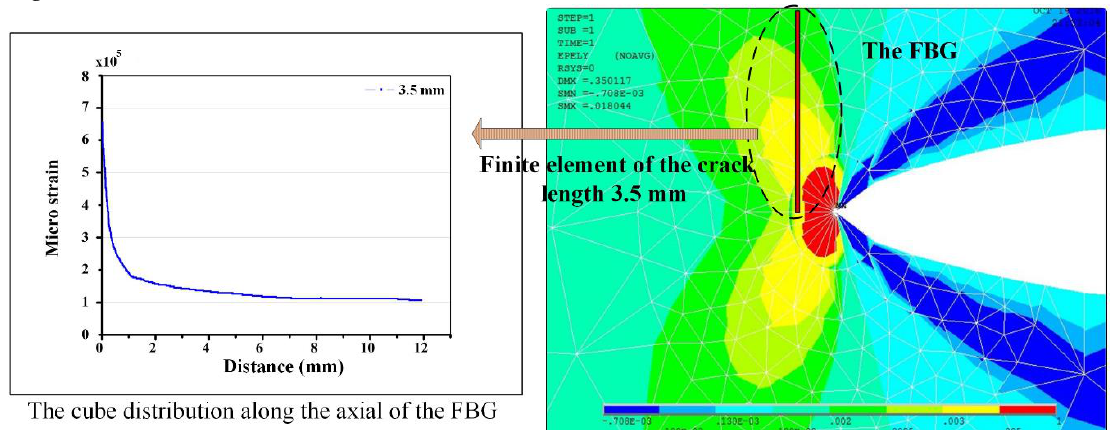
Figure 14. The stress distribution at the crack tip extracted by the Abaqus software.